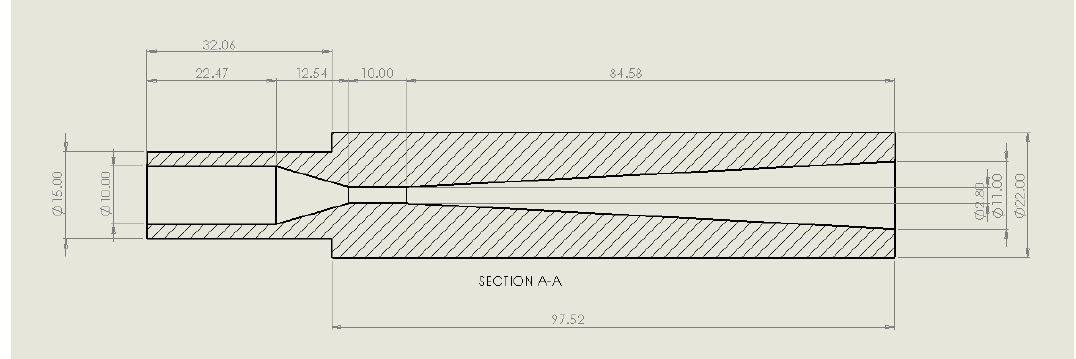
Figure 3. The 2 ‐ D sketch of Venturi ‐ type baseline microbubble Generator model. Figure 3. The 2-D sketch of Venturi-type baseline microbubble Generator